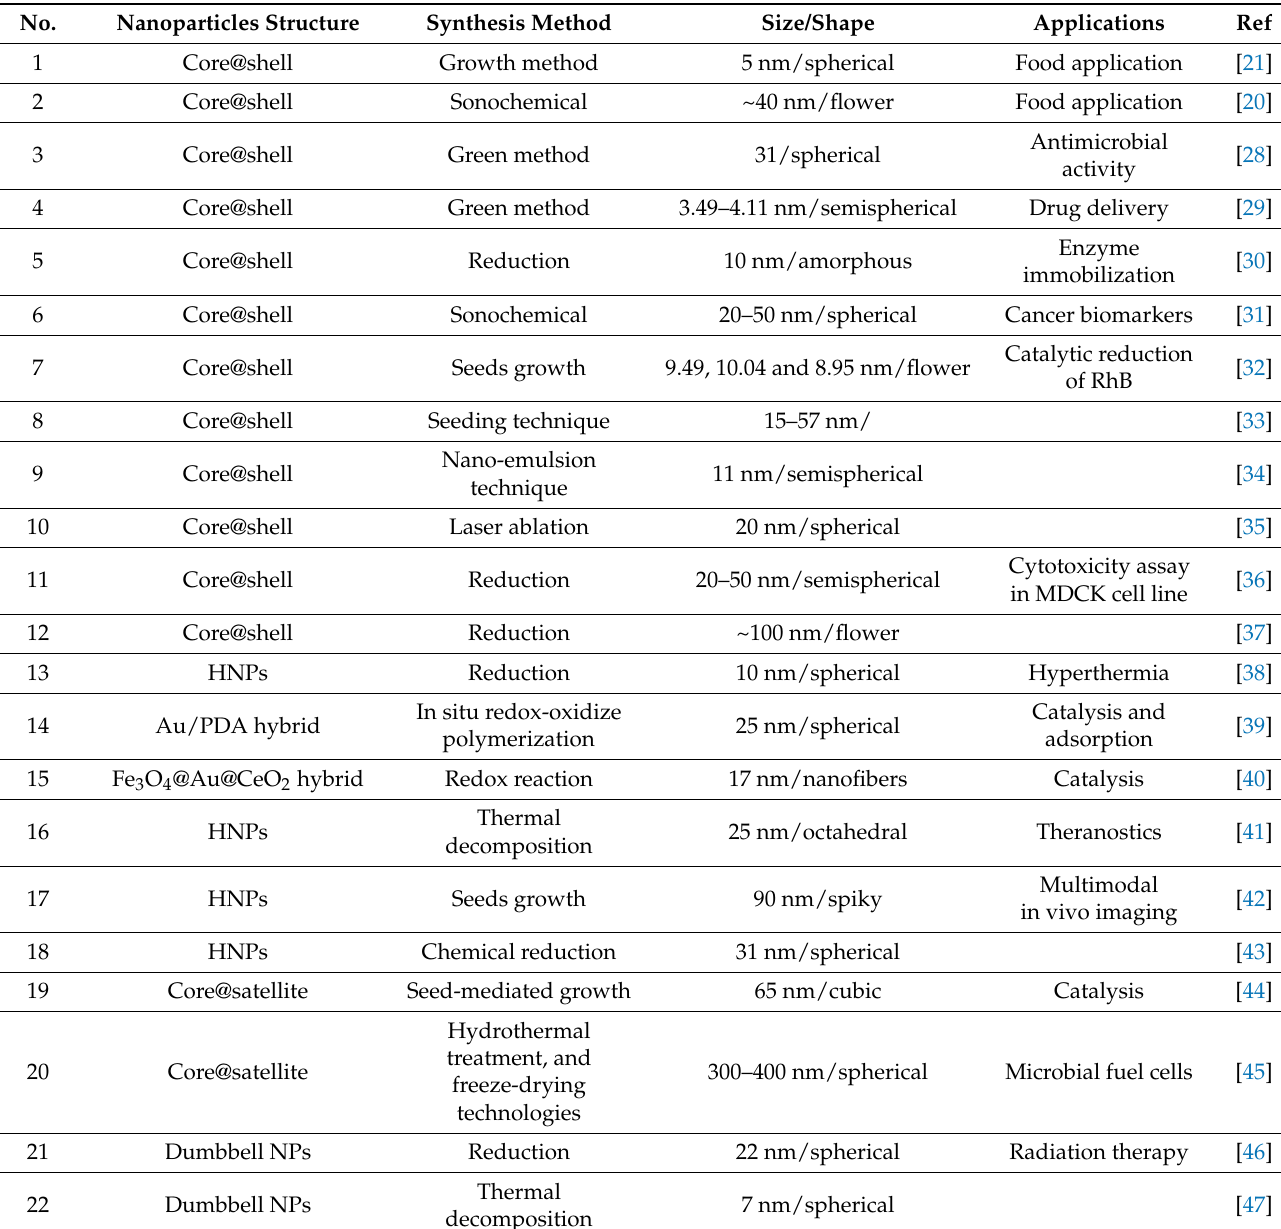
Table 1. Summary of the recently published studies on the synthesis methods of Fe 3 O 4 @Au NPs.